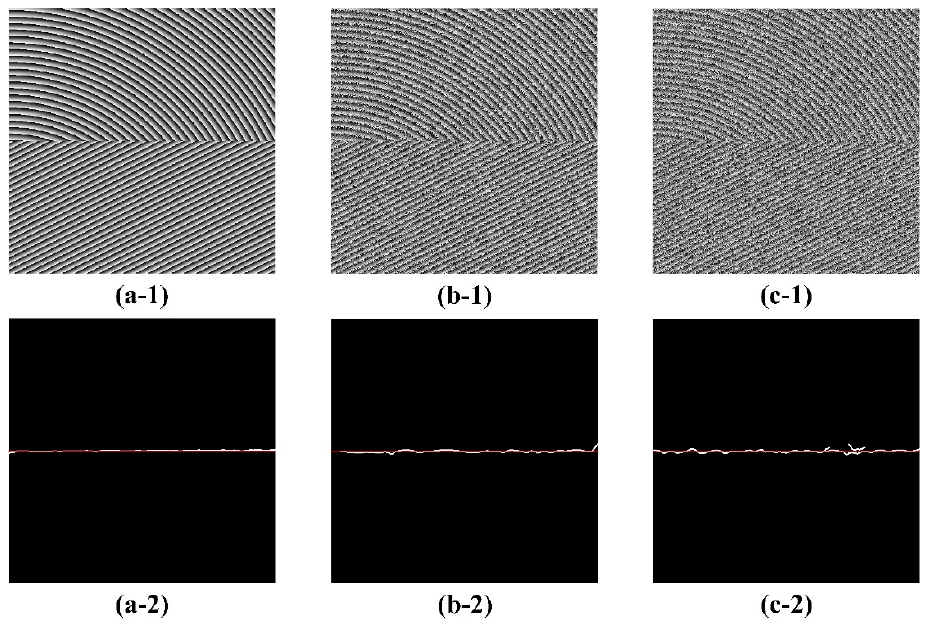
Figure 3. Simulated fringe patterns (LINE): ( a - 1 ) noiseless, ( b - 1 ) random noise (variance 0.8), ( c - 1 ) random noise (variance 1.5). Weight mask’s segmentation results: ( a - 2 ) noiseless, ( b - 2 ) random noise (variance 0.8), ( c - 2 ) random noise (variance 1.5).